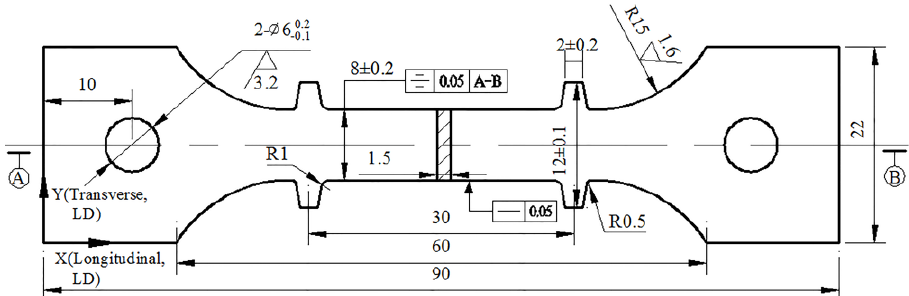
Figure 1. Specimens used for tensile tests in creep aging (unit: mm).